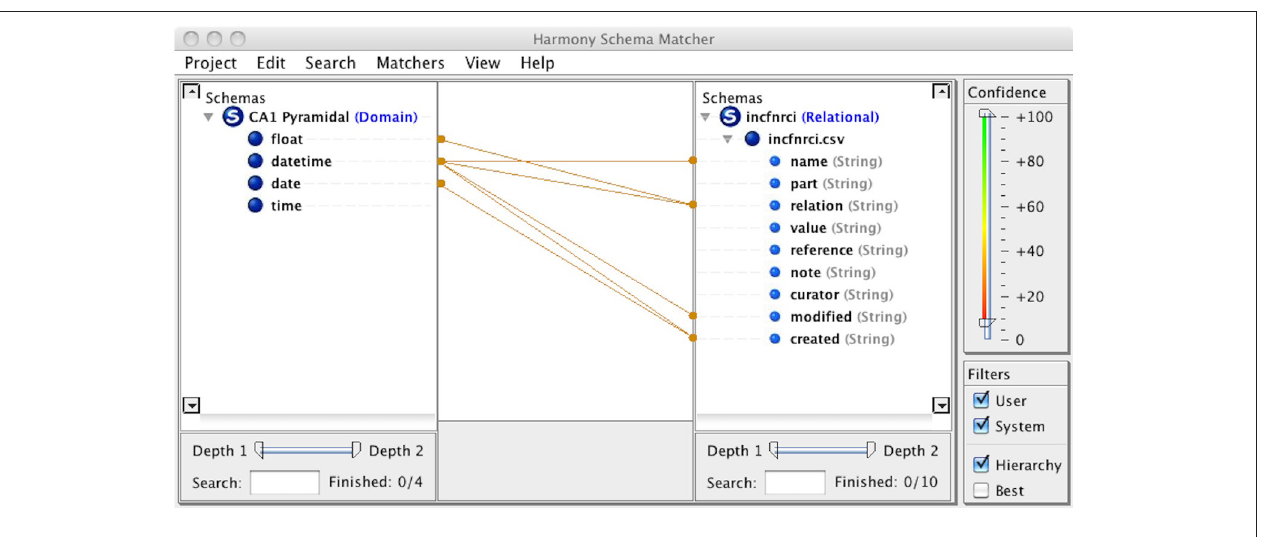
assists the implementer in mapping data types properly so as to preserve integrity of meaning. Both automated (e.g., pattern recognition) and manual (e.g., thresholding) techniques are leveraged in this